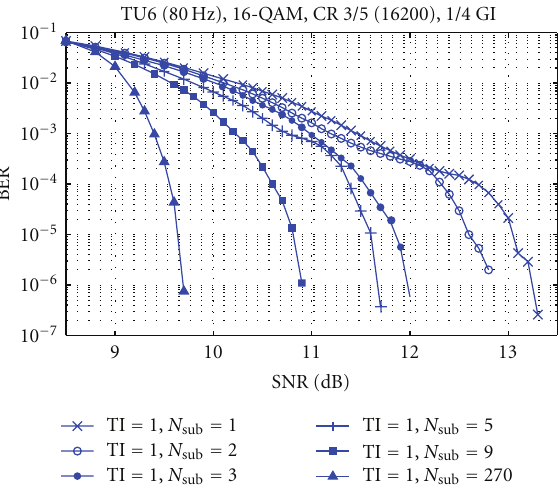
Figure 9: TU6 80Hz: time interleaving and subslicing comparison. Figure 10: TU6 80 Hz: subslicing comparison.